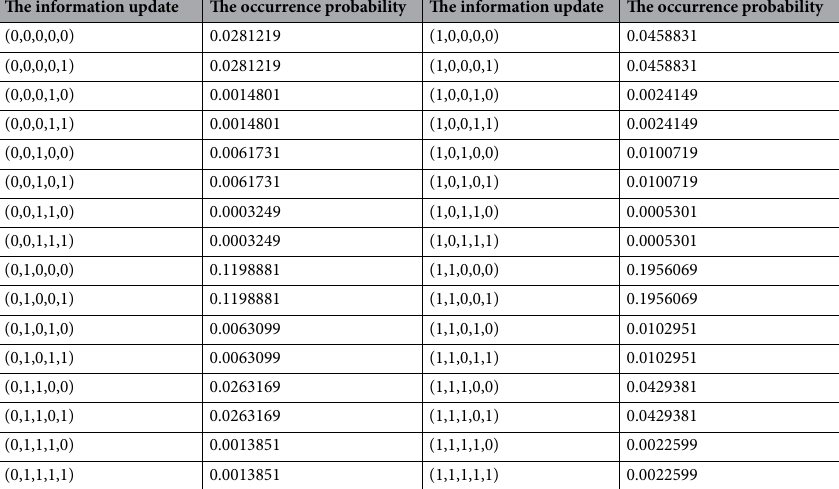
Table 2. The occurrence probabilities for every kind of information update.